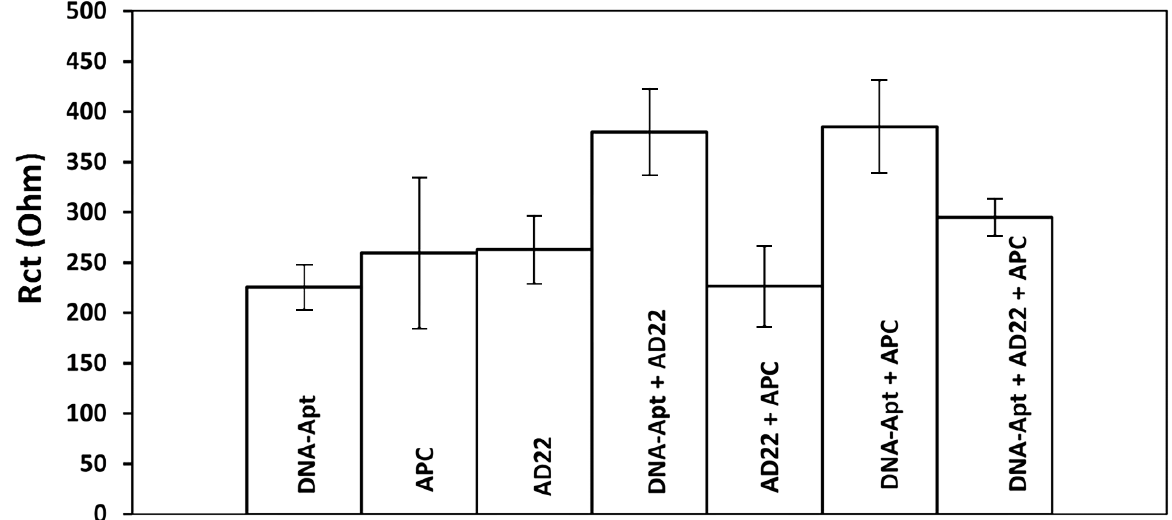
Figure 8. Histograms representing the average Rct values ( n = 3) obtained by the interaction of 0.1 µ g/mL DNA-Apt and 0.6 µ g/mL APC in the absence and presence of 0.1 µ g/mL AD22 in 1:2000 diluted